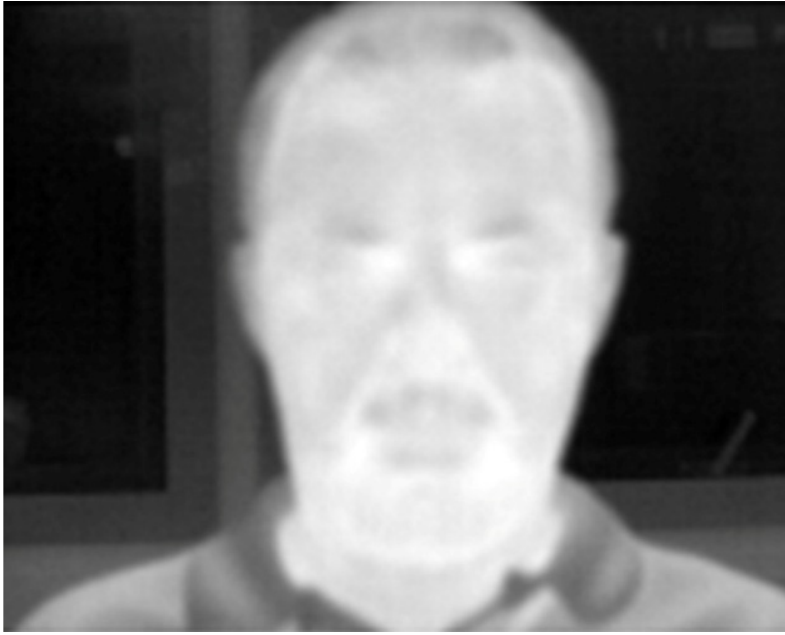
Figure 1. Mean value of the 50-frame multi-view acquisition of a specific intoxicated person.